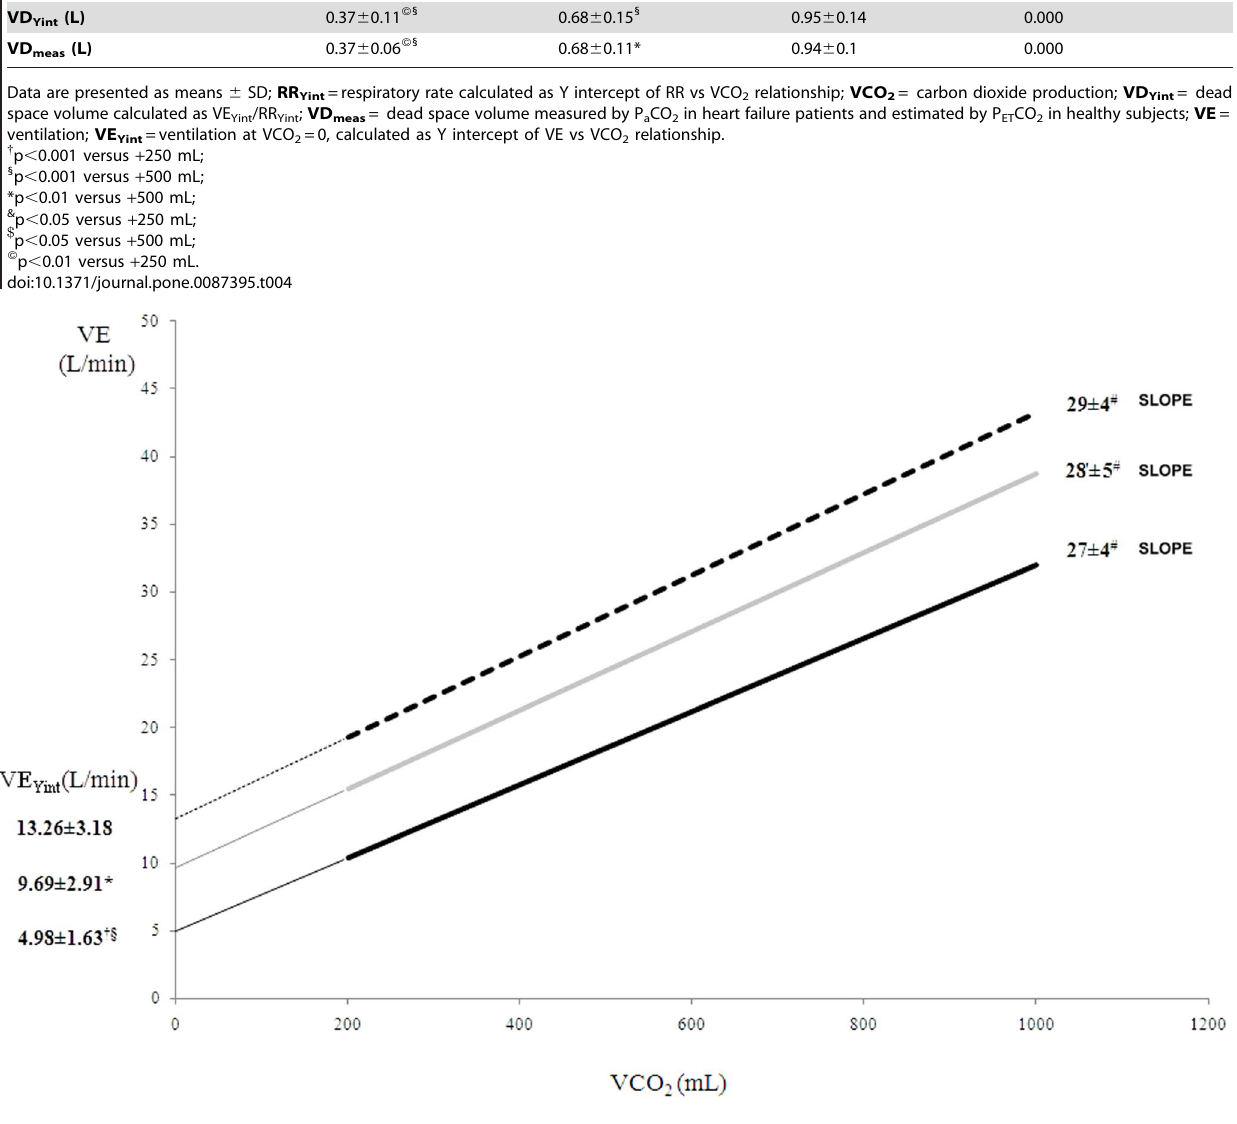
Figure 2. VE vs. VCO 2 relationship in heart failure patients with 0 mL (black line), 250 mL (grey line) and 500 mL (dotted line) of additional dead space (DS). The adding of DS uplifts the VE vs. VCO 2 relationship with a minor slope increase. { p , 0.001 versus + 250 mL; 1 p , 0.001 versus + 500 mL; * p , 0.01 versus + 500 mL; # p , 0.05 versus other all.